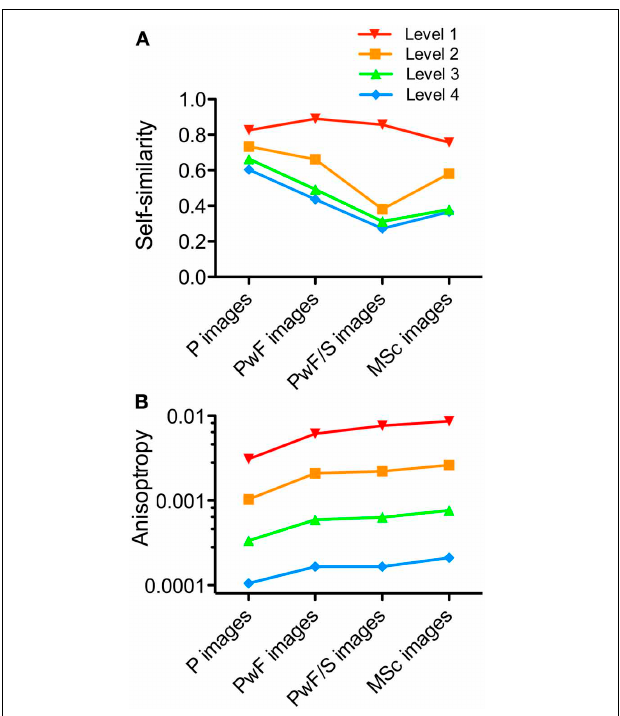
FIGURE 8 | Results for self-similarity (A) and anisotropy (B) at different levels of the PHOG analysis. The National Gallery dataset was analyzed. Image categories are indicated below the x axis. Colors indicate the different PHOG levels of analysis, as indicated above the graph.